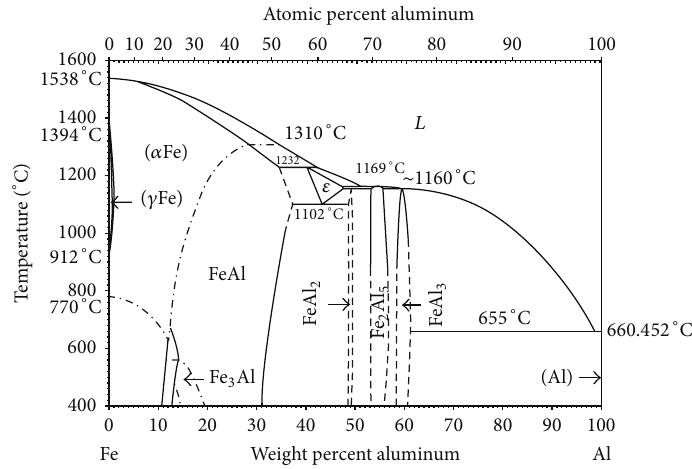
Figure 1: Equilibrium diagram for the aluminium-iron system (according to [15]).